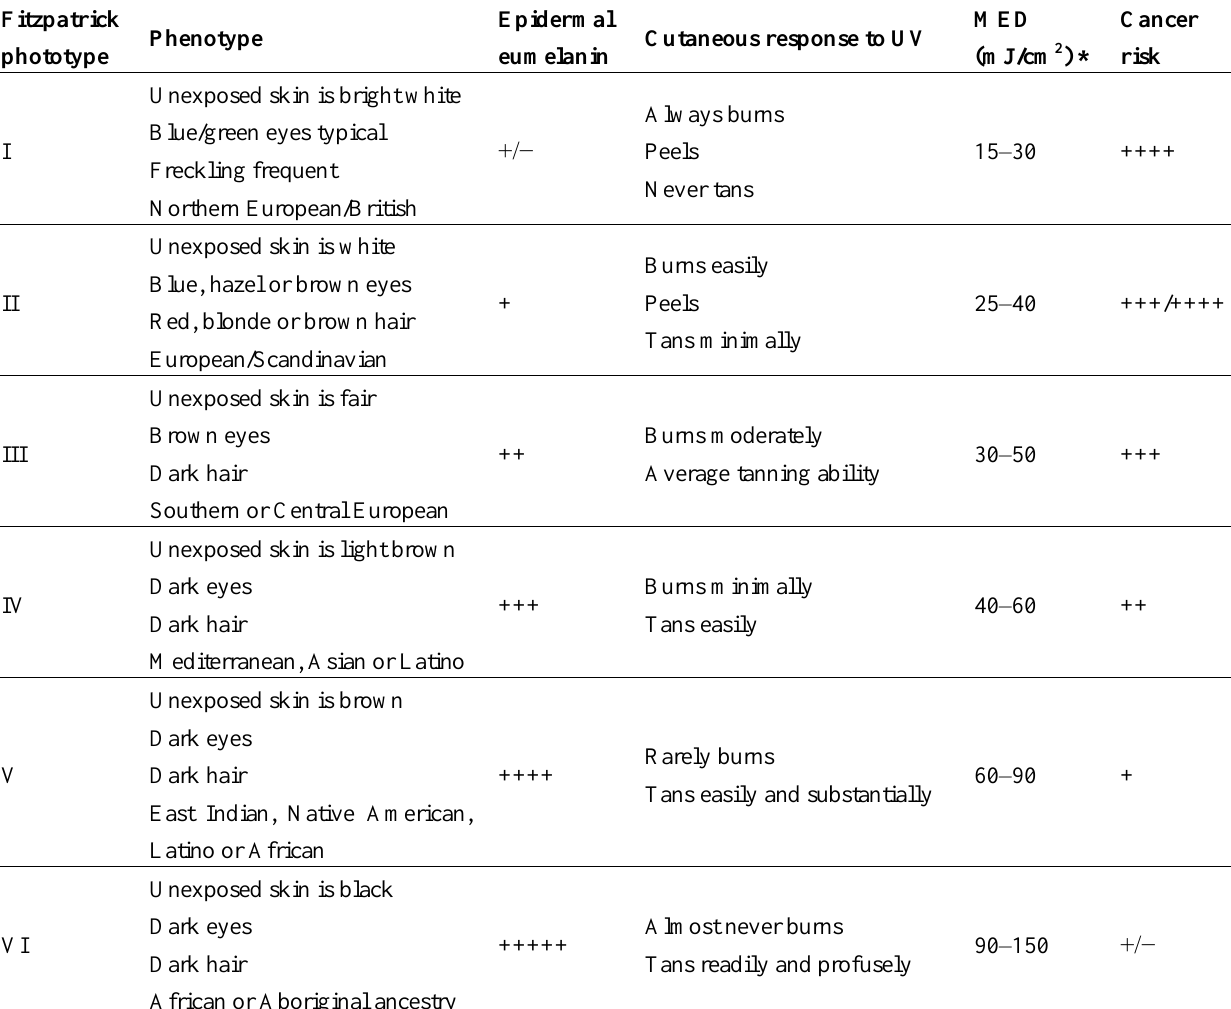
Table 1. Skin pigmentation, the Fitzpatrick scale and UV